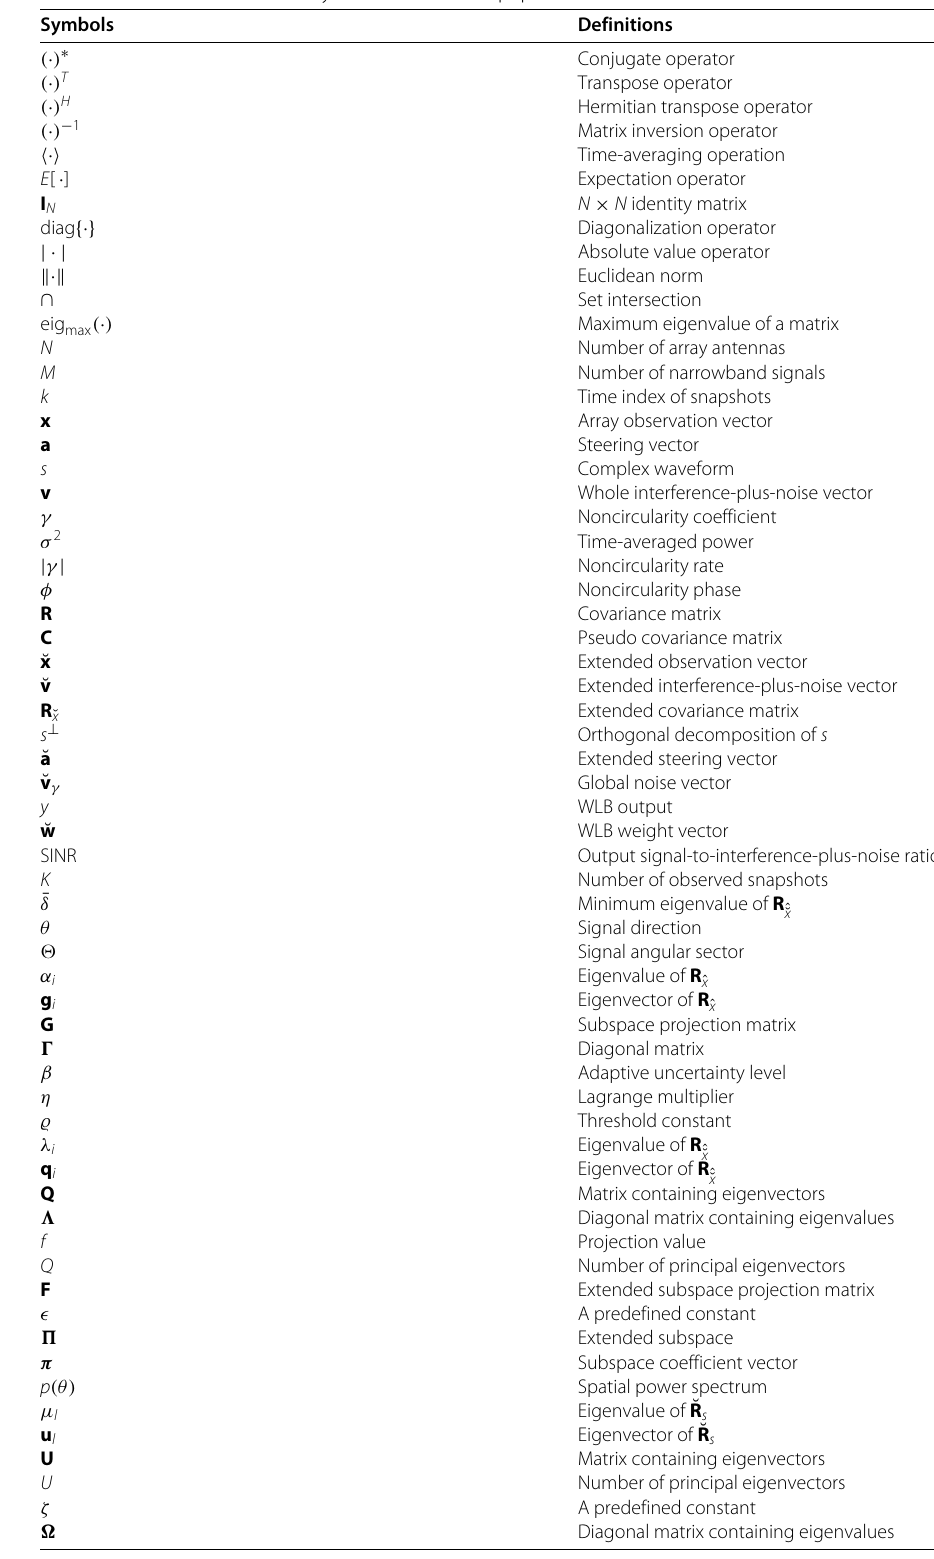
Table 1 The definitions of the symbols used in the paper